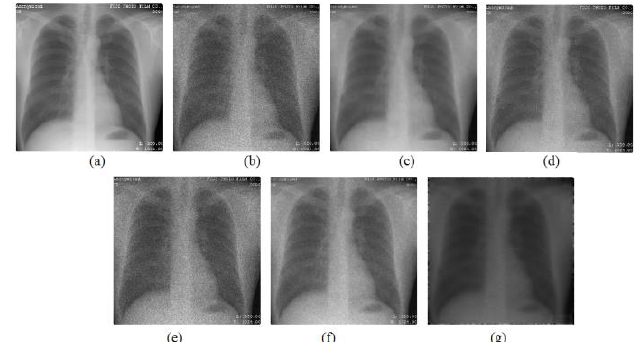
Figure2: (a) Original CR sample image, (b) Noisy image, Denoised images by: (c) PURE-LET, (d) MS-VST, (e) Exact unbiased inverse of the VST, (f) Total variation, (g) PDE-based method.